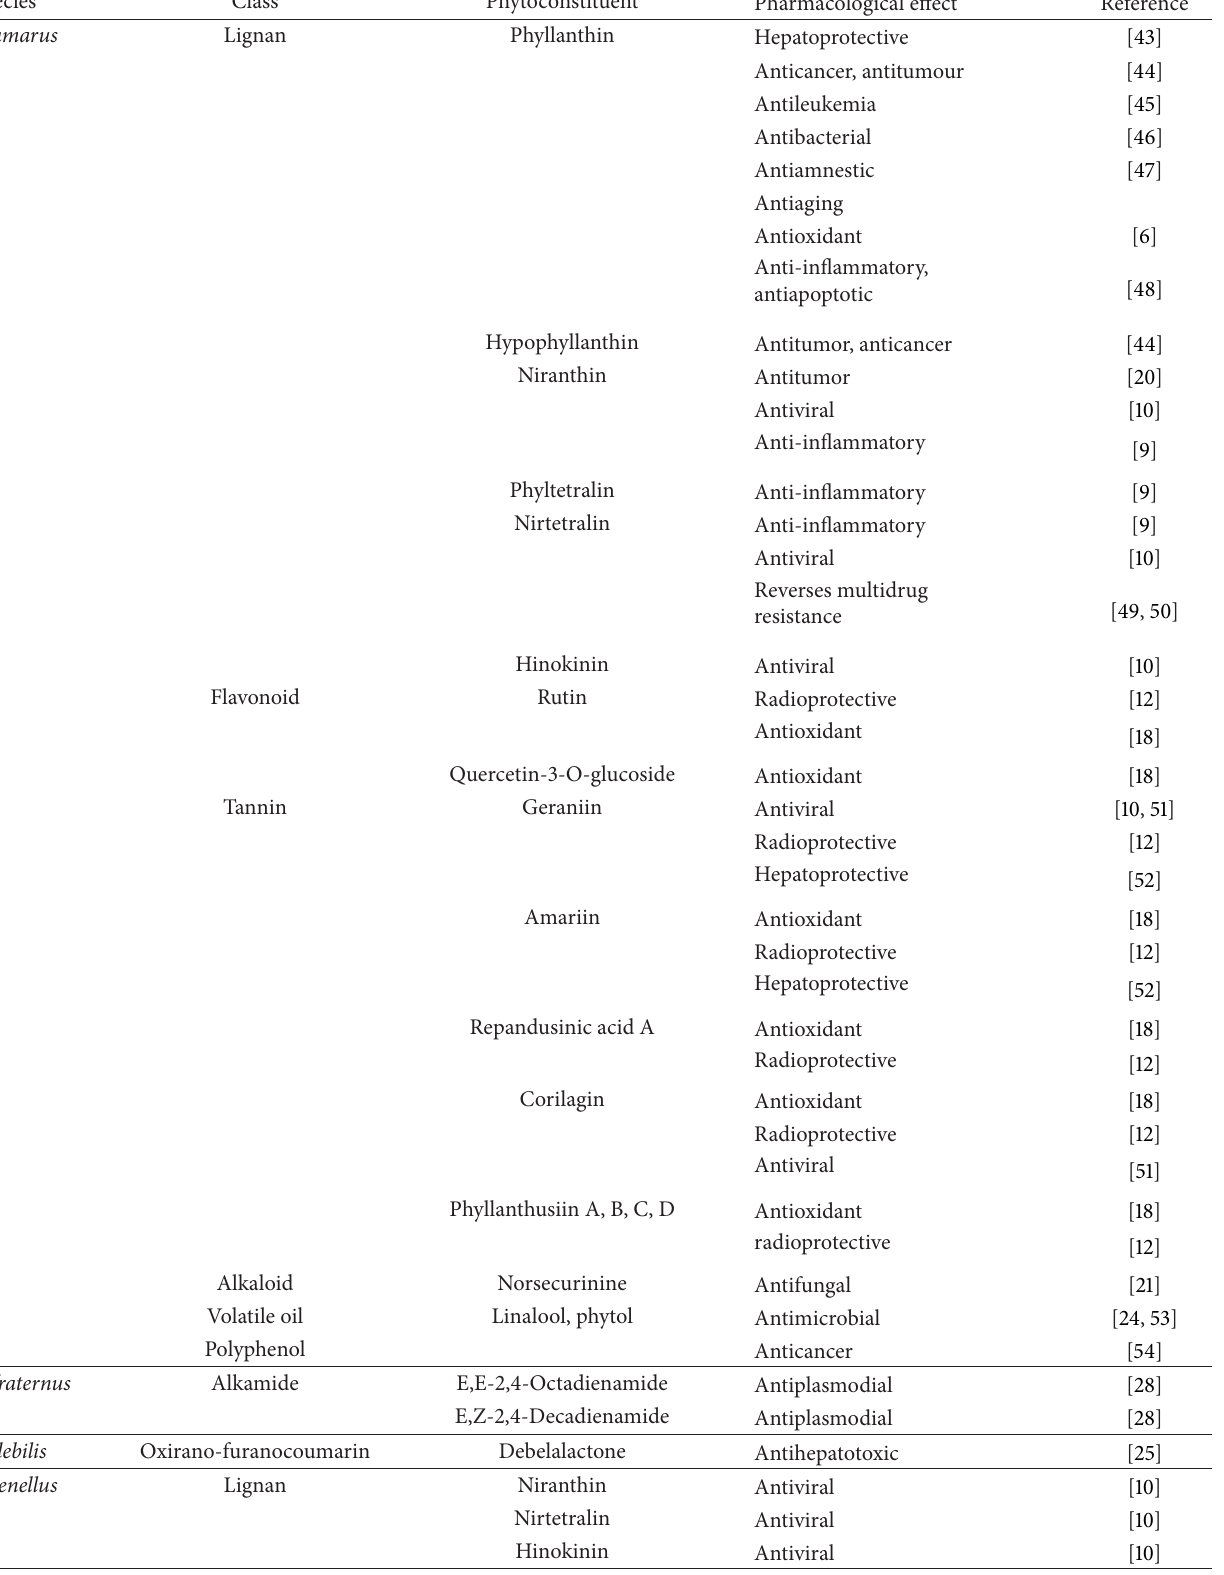
Table 2: Pharmacological effect of major phytochemicals in Phyllanthus amarus , P. debilis , P. fraternus , P. tenellus , P. urinaria , and P. virgatus .